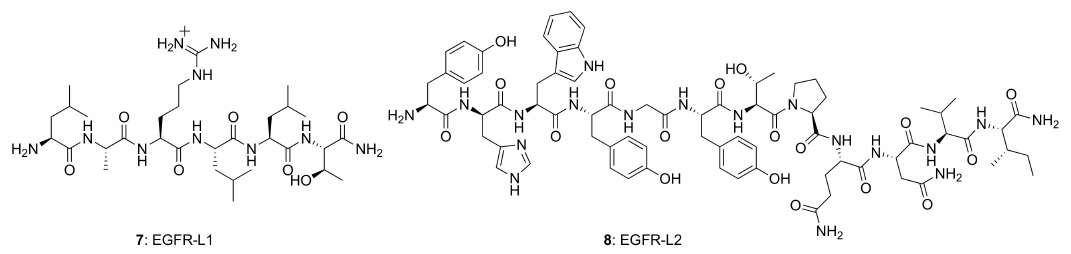
Figure 6. Structures of EGFR-targeting peptides, EGFR-L1 and EGFR-L2.